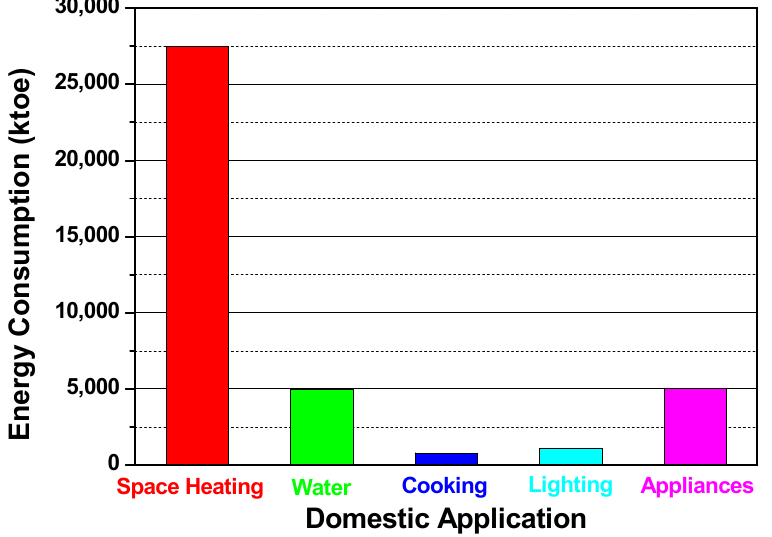
Figure 1. United Kingdom (UK) Residential Energy Use per Application [7].